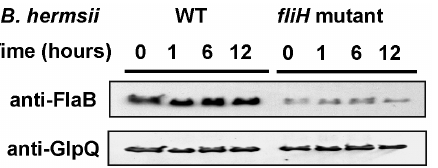
Figure 7. Stability of FlaB in wild-type (WT) B.hermsii and the fliH mutant. Lysates from spirochetes treated with 100 m g/ml of spectinomycin were analyzed by immunoblot using anti-FlaB and anti- GlpQ antibodies at the different time points